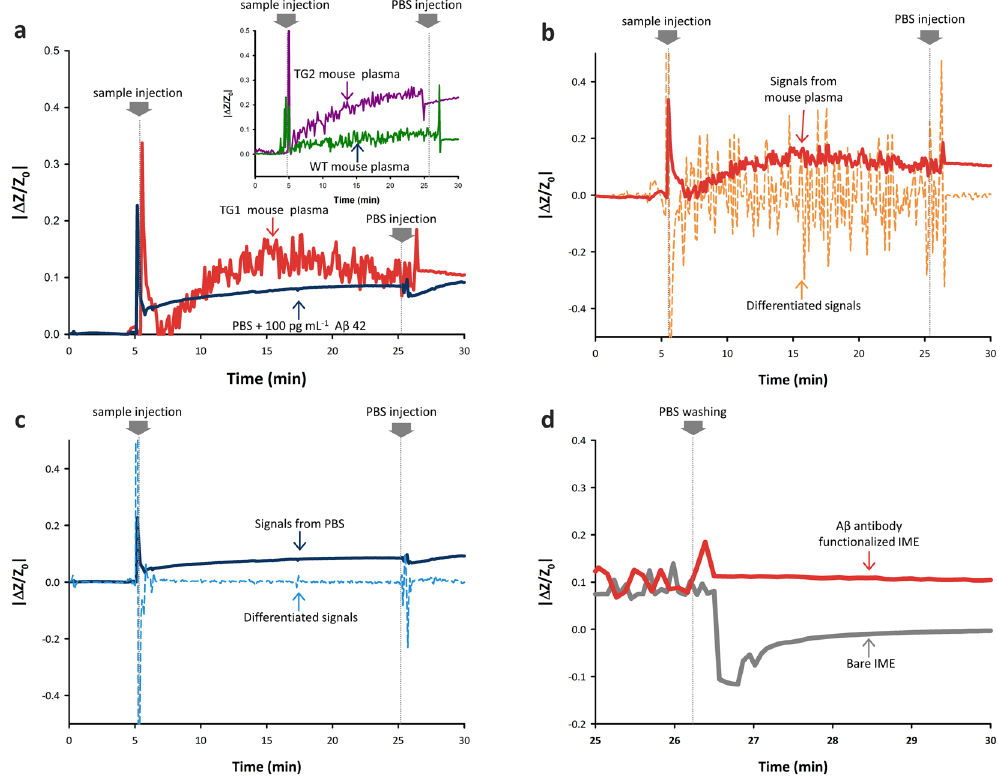
Figure 4. Compatibility test for medium change. ( a ) Real-time detection of A β in plasma (TG 1, TG 2 and WT mouse) and PBS. ( b , c ) Comparison between signals and differentiated signals from mouse plasma and PBS with A β . ( d ) The medium change test for A β detection using A β -antibody-immobilized and bare